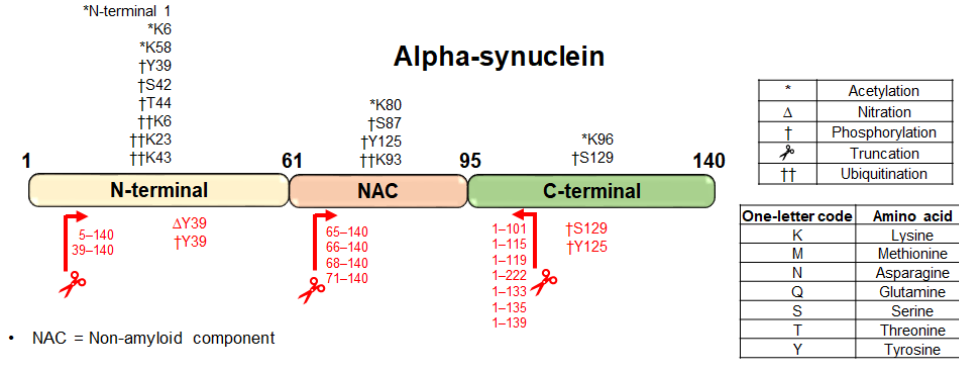
Figure 3. Schematic representation of post-translational modifications (PTMs) identified in α -synuclein. The red text indicates putative disease-specific modifications reported in PD [98 – 110], while black test indicates all known modifications that are reported in the literature and proteomic databases (ProteomicsDB and PhosPhosite).